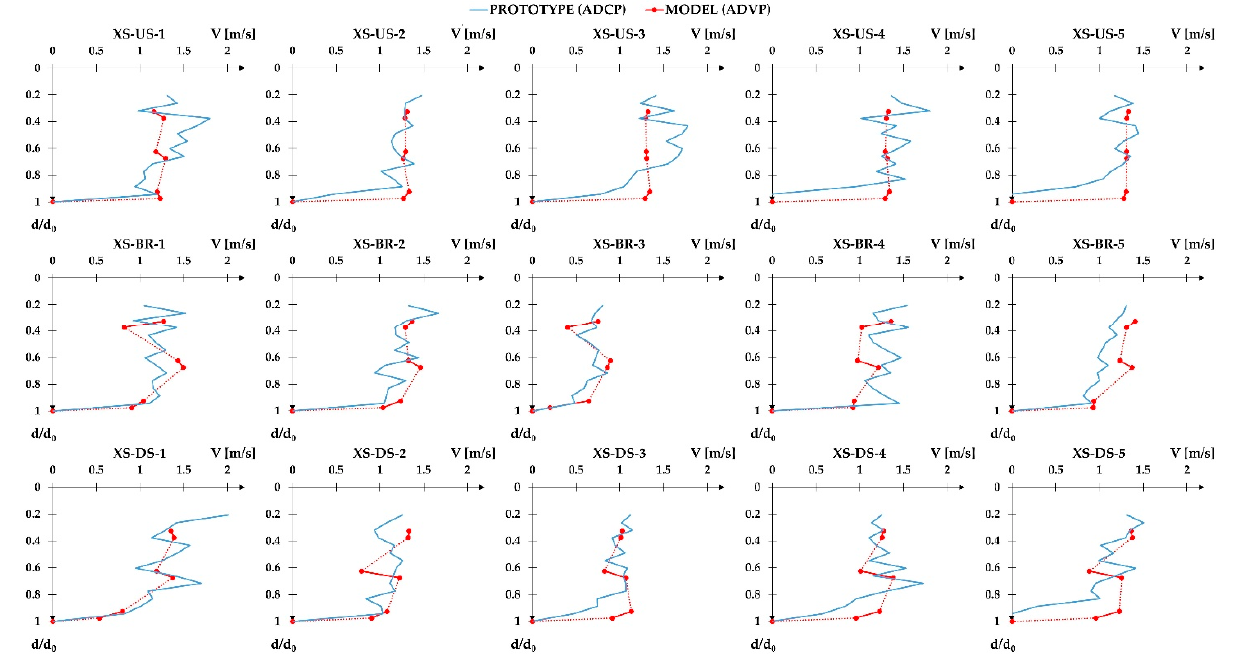
Figure 9. Comparison of flow velocity profiles measured for the prototype conditions (ADCP) and experimental conditions (ADVP).